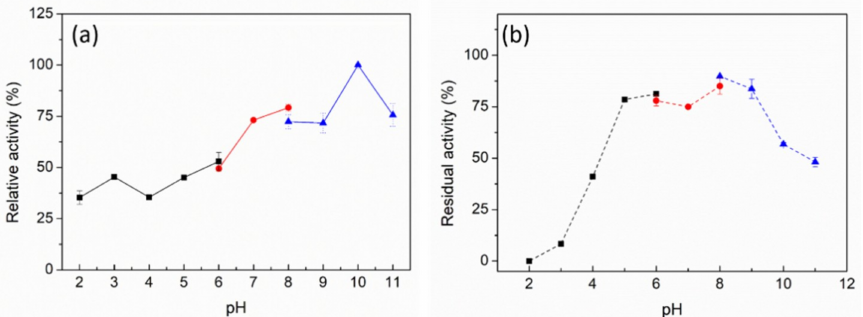
Figure 3. E ff ect of pH on activity ( a ) and stability ( b ) of PpPel9a. The enzyme activity was detected